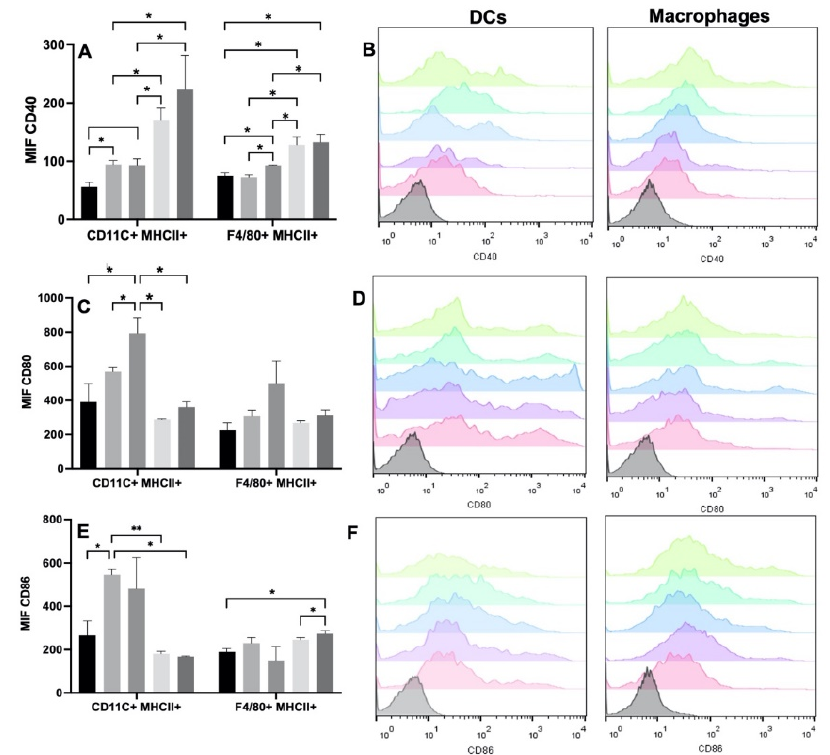
Figure 4. Expression of costimulatory molecules in DC (CD11c+ MHCII+) and macrophages (F4/80+ MHCII+) after treatment with Ge/HA scaffolds coupled to MAGE/A5 or CpG. Without treatment, Ge/Ha, CpG, MAGE-A5, MAGE-A5/CpG. ( A ) CD40 expression. ( B ) Representative histograms of CD40 expression in DC and macrophages. ( C ) CD80 expression. ( D ) Representative histograms of CD80 expression in DC and macrophages. ( E ) Expression of CD86. ( F ) Representative histograms of CD86 expression in DC and macrophages. No significant changes were found in the levels of macrophages and DC after the treatments. Regarding costimulatory molecules, the in- crease in CD40 expression was evident in DC among all experimental groups (* p = 0.012: Ge/HA vs. WT, Ge/HA/MAGE-A5, Ge/HA/MAGE-A5/CpG; Ge/HA/CpG vs. Ge/HA/MAGE-A5 and Ge/HA/MAGE-A5/CpG). Macrophages also showed increased CD40 expression in the groups treated with Ge/HA/CpG, Ge/HA/MAGE-A5, and Ge/HA/CpG/MAGE-A5 compared to the WT group and among the other experimental groups (* p = 0.0125: Ge/HA/CpG vs. WT, Ge/HA, Ge/HA/MAGE-A5, Ge/HA/MAGE-A5/CpG, Ge/HA/MAGE-A5 vs. WT, Ge/HA, Ge/HA/CpG, Ge/HA/CpG/MAGE-A5). In the case of CD80 in DC, Ge/HA scaffolds alone or coupled to CpG induced increased CD80 expression vs. cells treated with the other groups (* p = 0.013, Ge/HA/CpG vs. Ge/HA, * p = 0.013 Ge/HA/CpG vs. Ge/HA/MAGE-A5 and Ge/HA/MAGE-A5/CpG). When the effect of scaffolds on CD86 was analyzed, only Ge/HA scaffolds induced increased expression in DC compared to WT, Ge/HA/MAGE-A5 and Ge/HA/MAGE-A5/CpG (** p = 0.006: Ge/HA vs. Ge/HA/MAGE-A5; * p = 0.012: Ge/HA vs. WT and Ge/HA/MAGE-A5/CpG). In contrast, macrophages showed increased expression of CD86 when treated with Ge/HA/MAGE/CpG com- pared to the WT group and Ge/HA/MAGE-A5 (* p = 0.04: Ge/HA/MAGE-A5/CpG vs. WT,